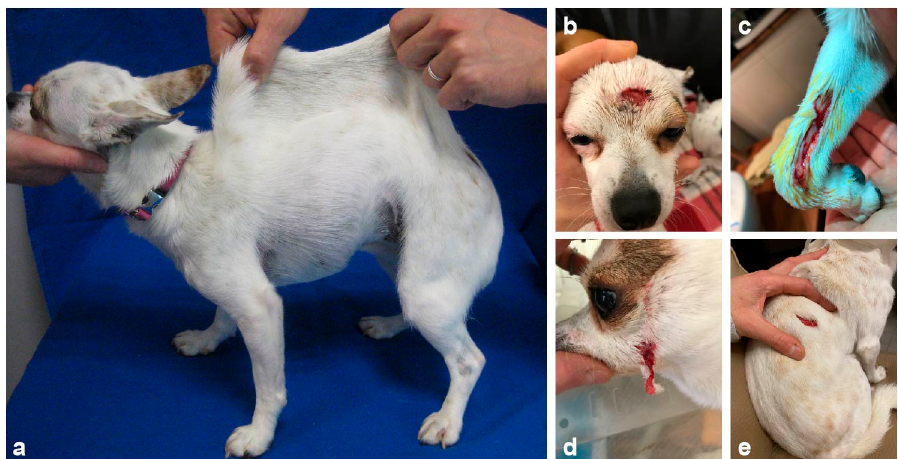
Figure 1. Clinical signs of the classical Ehlers-Danlos-affected Chihuahua dog. ( a ) Skin hyperexten- sibility over the dorsum. ( b ) Skin laceration resulting from minimal trauma on the head, ( c ) on the forelimb, ( d ) on the lower jaw, and ( e ) on the dorsum.